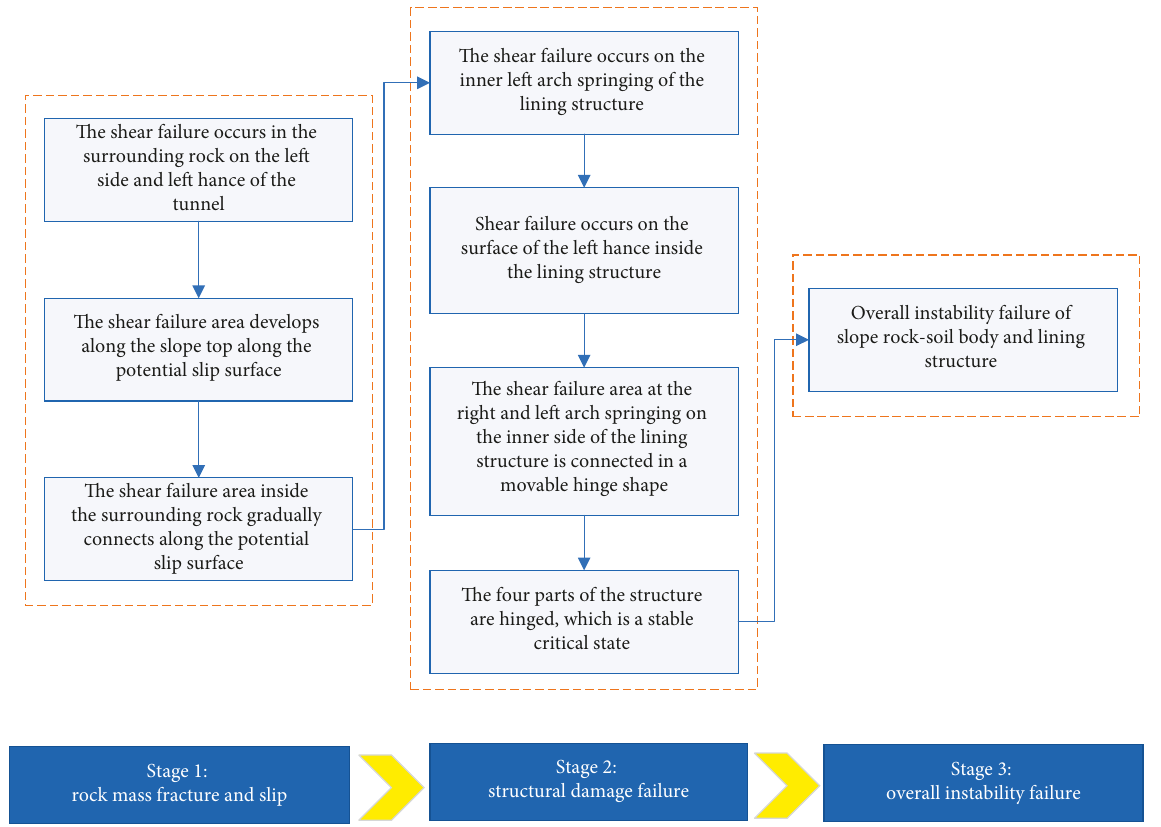
Figure 10: Progressive instability failure process of the shallow tunnel under unsymmetrical